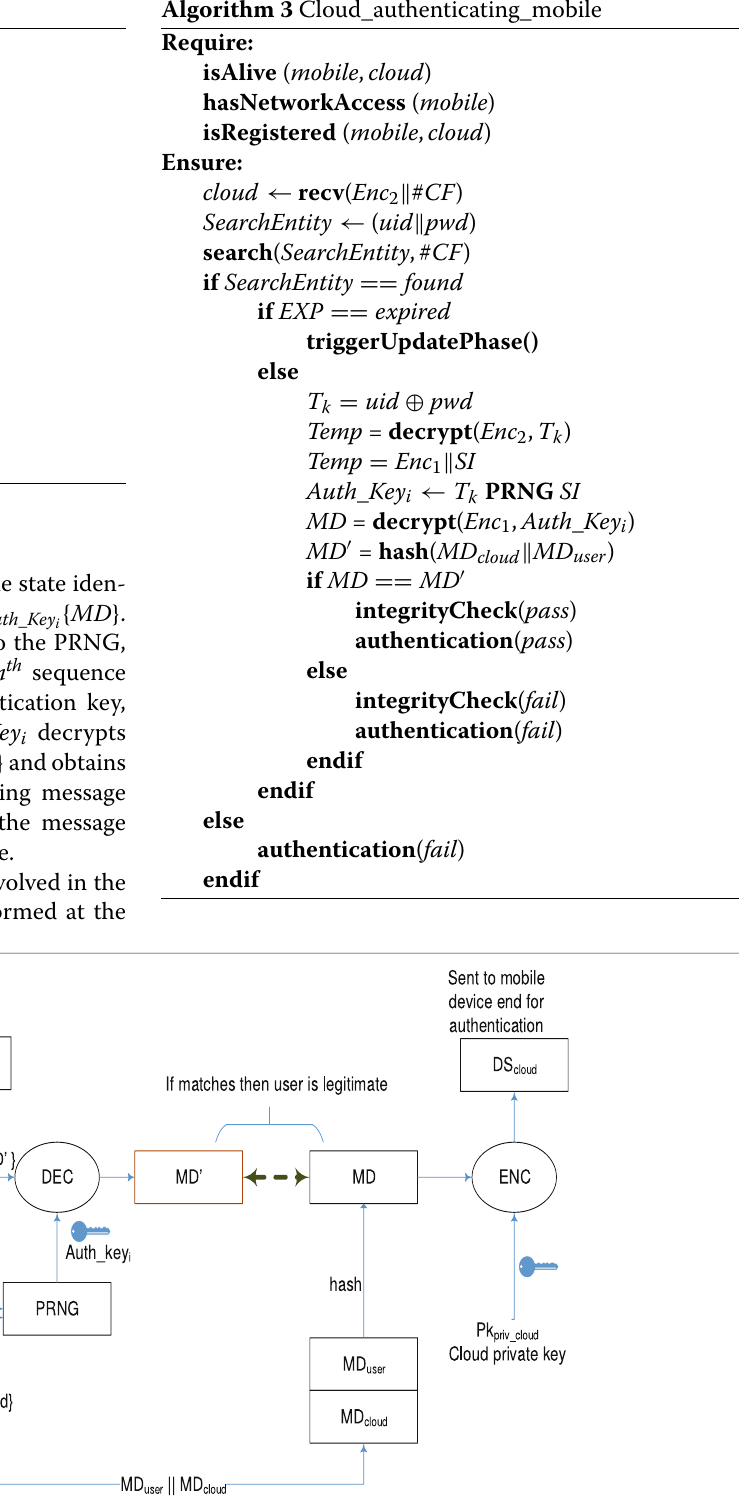
(cid:3) (cid:2) { MD }(cid:3) SI to the cloud server, which is encrypted with key T k E Auth _ Key i k